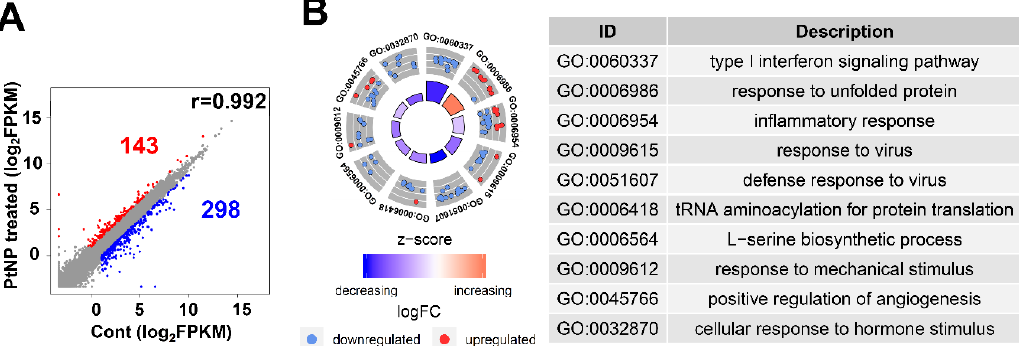
Figure 12. PtNP treatment causes a change in gene expression. ( A ) Scatter plot representing expression profile of PtNP-treated and control samples. The red portion represents upregulated differentially expressed genes (DEGs) and the blue portion represents the downregulated DEGs in the PtNP-treated sample relative to the control sample. ( B ) A plot of gene ontology (GO) circle produced with biological processes of DEGs from the Database for Annotation, Visualization and Integrated Discovery (DAVID). Red dots and blue dots represent upregulated and downregulated genes, respectively. Each GO term is noted with a unique GO number.